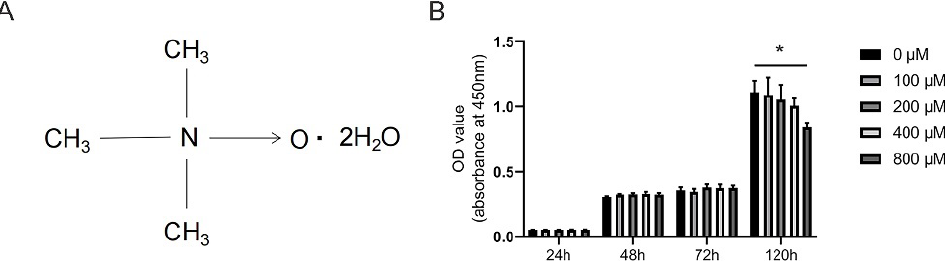
Figure 1. Effects of TMAO on the viability of BMMs. ( A ) Molecular structure of TMAO. ( B ) The cell viability of BMMs after treatment with different concentrations of TMAO for 24, 48, 72, and 120 h was evaluated by CCK-8. The cell viability of BMMs decreased significantly at 120 h with 800 µ M TMAO treatment; * p < 0.05.